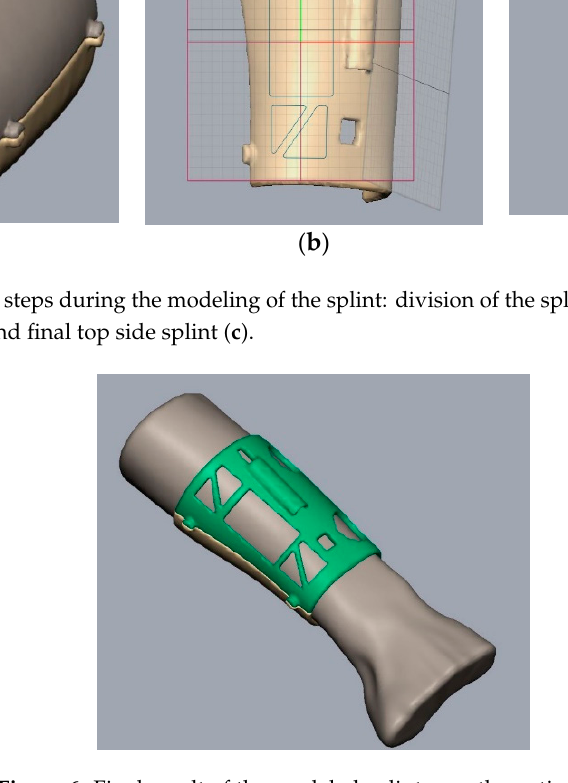
Figure 6. Final result of the modeled splint over the patient arm.